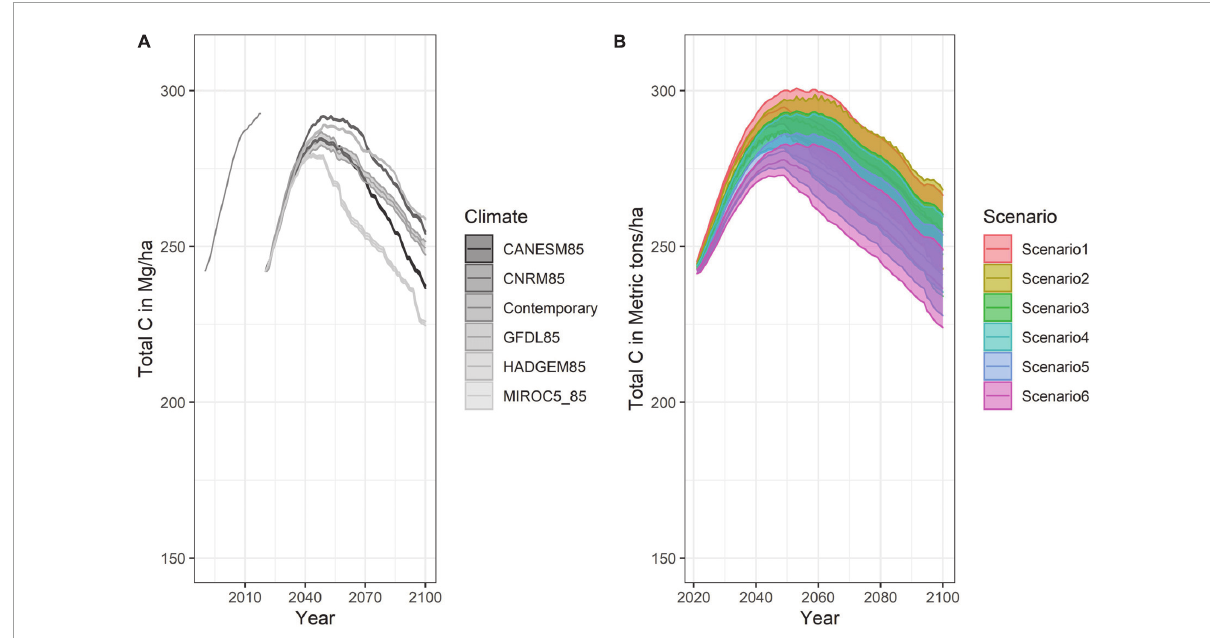
FIGURE7 Total Carbon in Mg ha - 1 for all scenarios averaged across climate projection (A) and for all climates averaged across management scenarios (B)